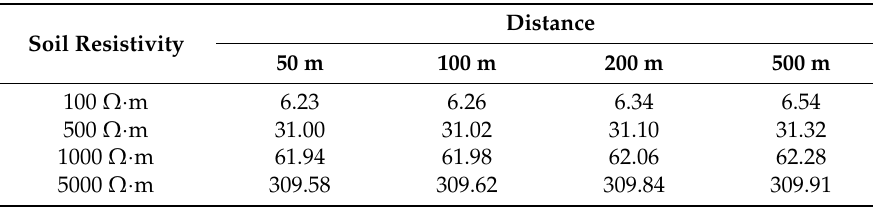
Table A1. Scenario 1a. Overall grounding resistance.